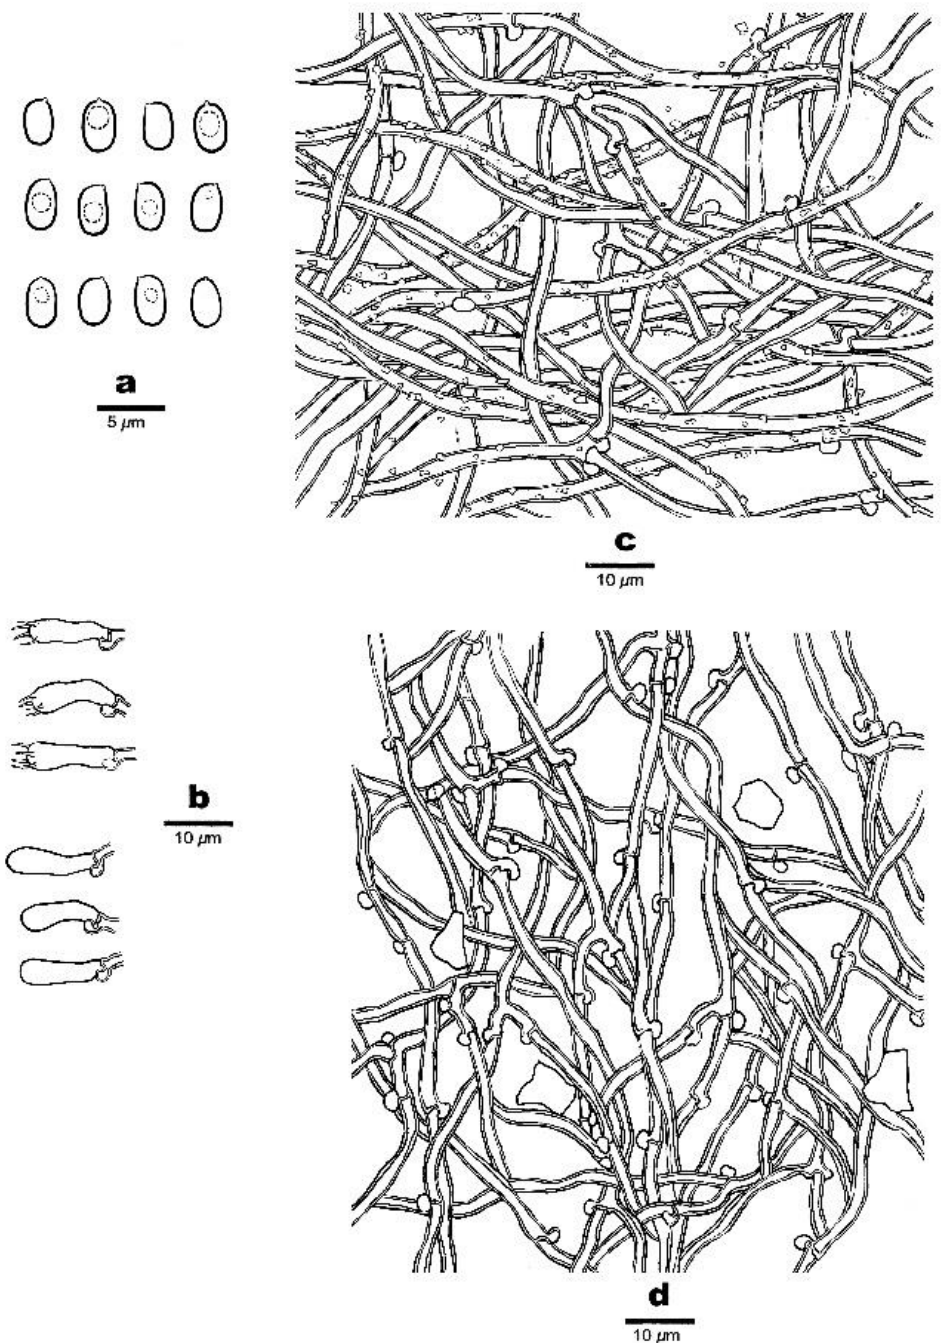
Figure 5. Micro-morphology of Anomoloma eurasiaticum (Dai 22860). ( a ) Basidiospores. ( b ) Basidia and basidioles. ( c ) A section of subiculum. ( d ) A section of trama.